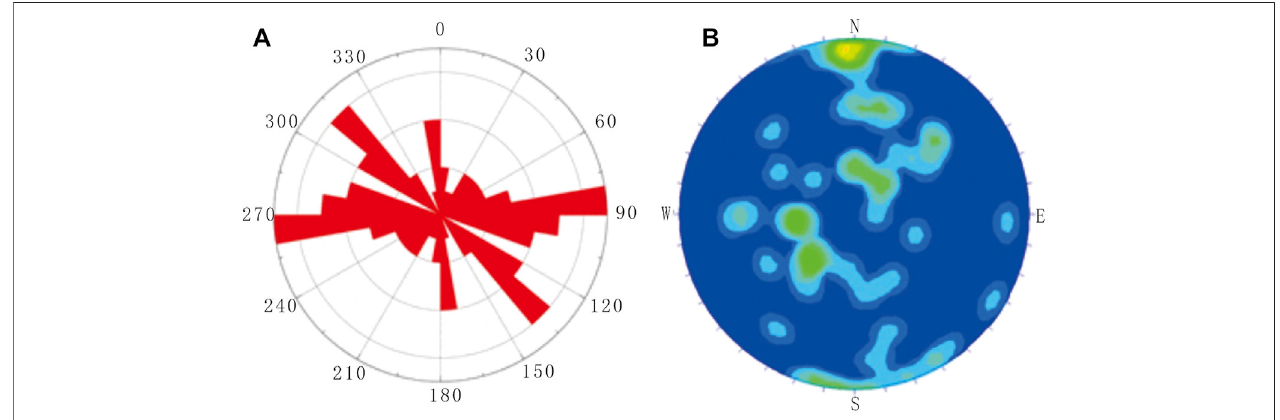
FIGURE 6 | The statistic maps of structural fractures in the second member of Jialingjiang formation, Puguang area (A) the rose diagram of the fracture strike (B) The equal density map of the fracture dip directions and dips.